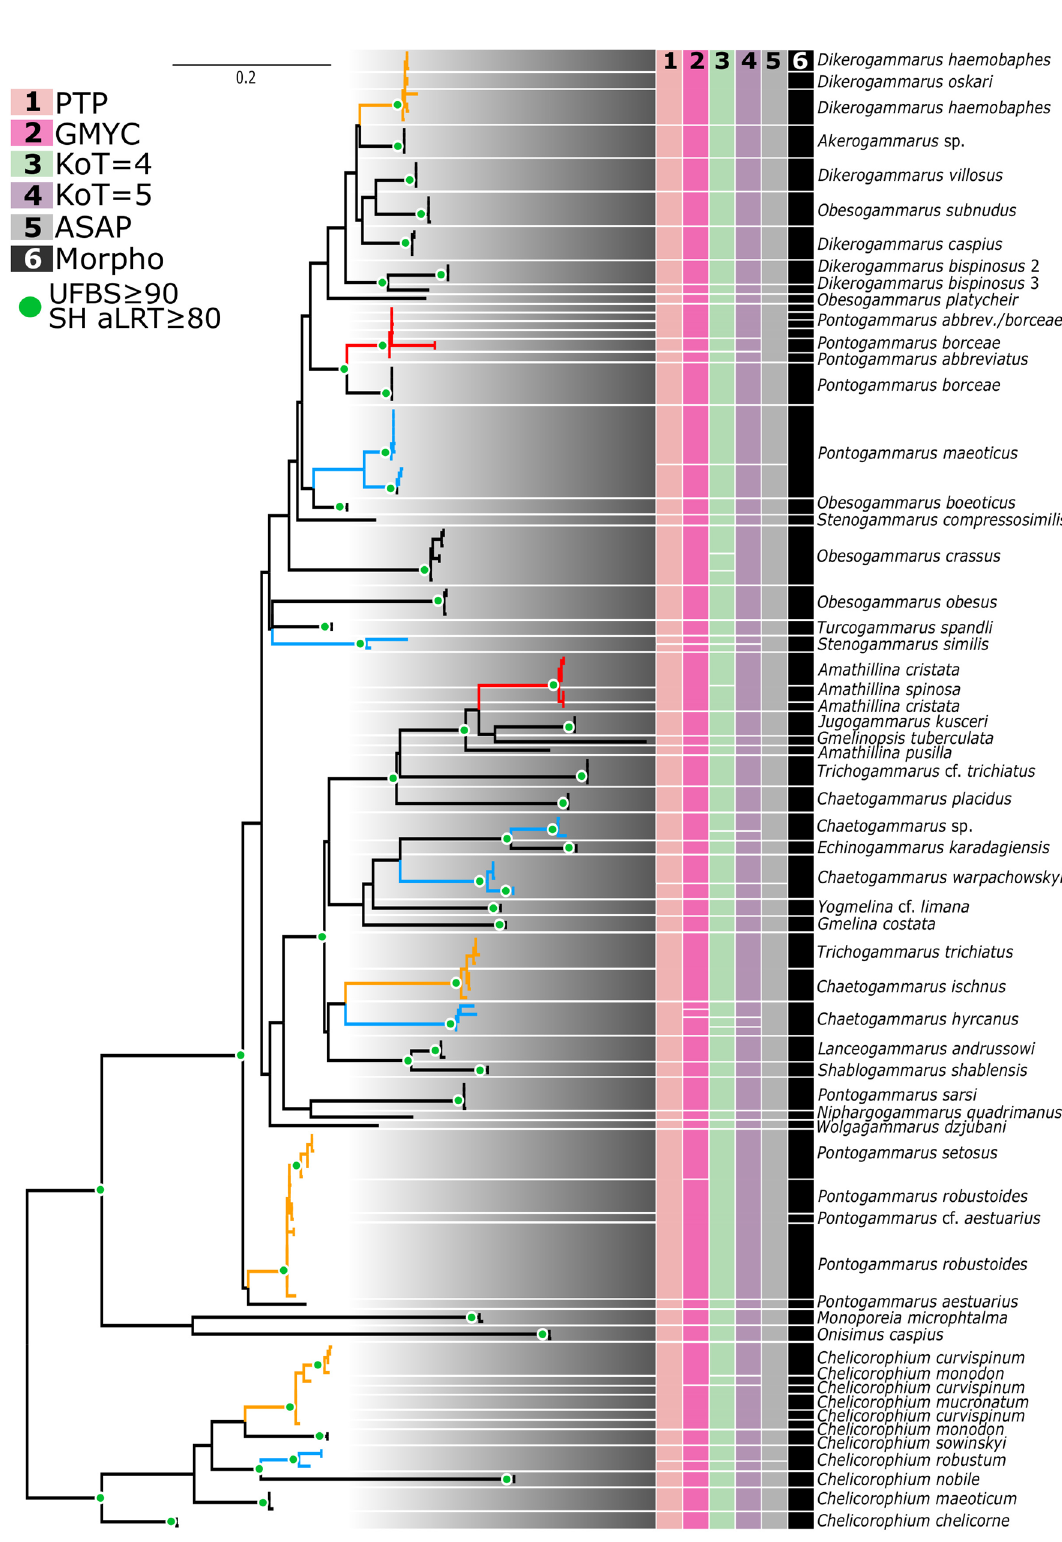
Figure 3. Maximum-likelihood 16S tree and species delimitation results. For details see legend on Fig. 2. The fully annotated tree is provided in the supplementary Fig.